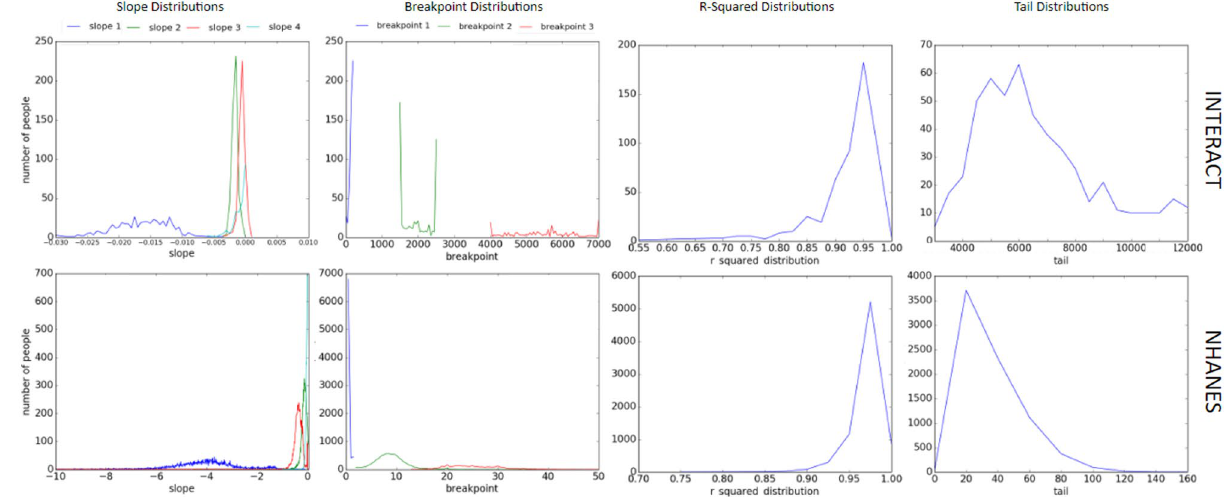
Figure 3. The distributions of the four slope metrics, the three breakpoint metrics, the R 2 values, and the tail metrics for both INTERACT (top) and NHANES